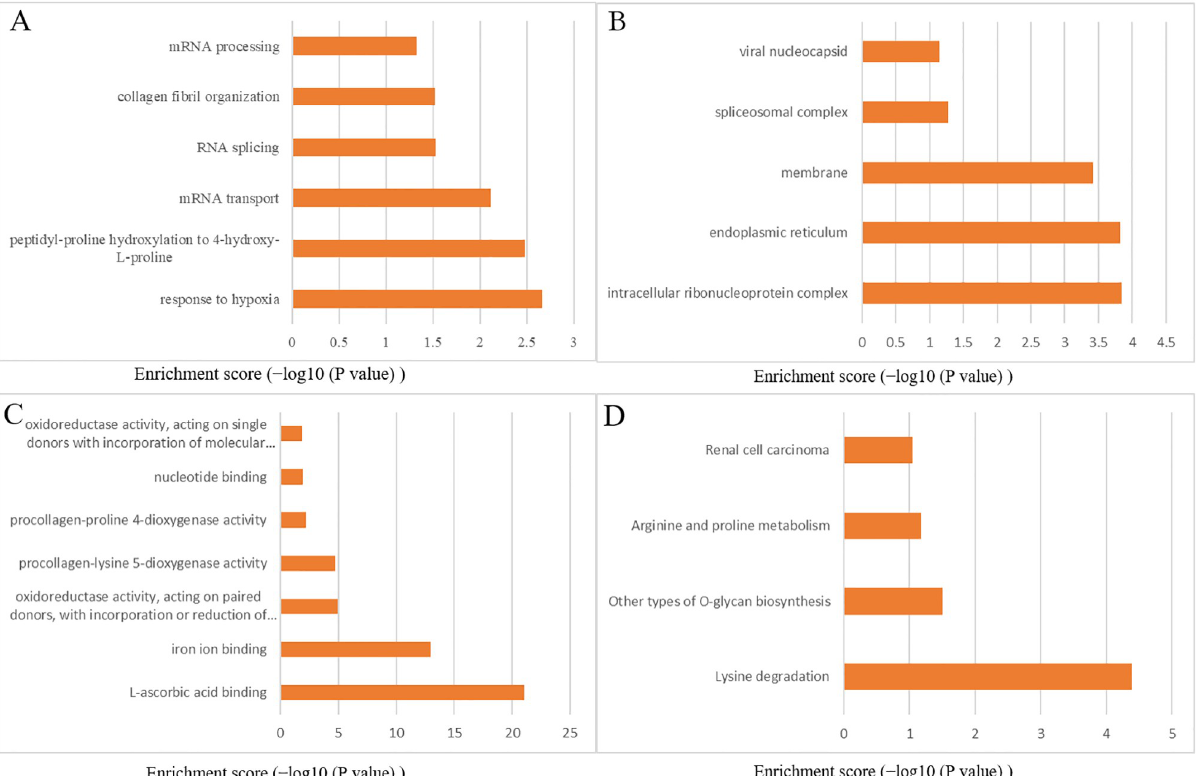
Fig 5. GO annotation and KEGG pathway enrichment analysis of PLOD family members in LGG. The top enriched GO (A) BP, (B) CC and (C) MF terms as well (D) KEGG pathways. GO, gene ontology; KEGG, Kyoto encyclopedia of genes and genomes; BP, biological process; CC, cellular component; MF, molecular